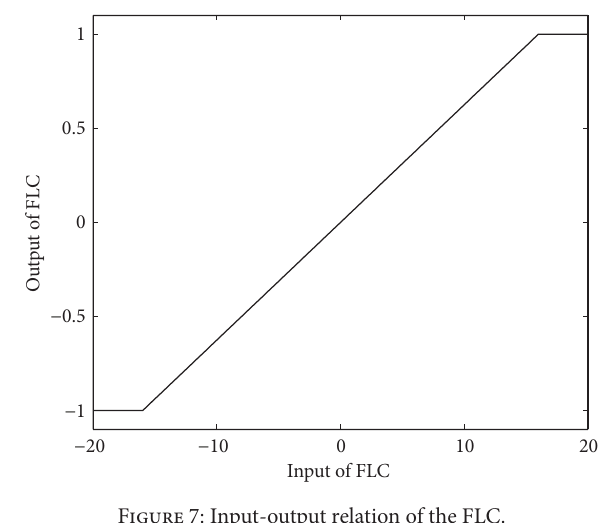
Figure 7: Input-output relation of the FLC.